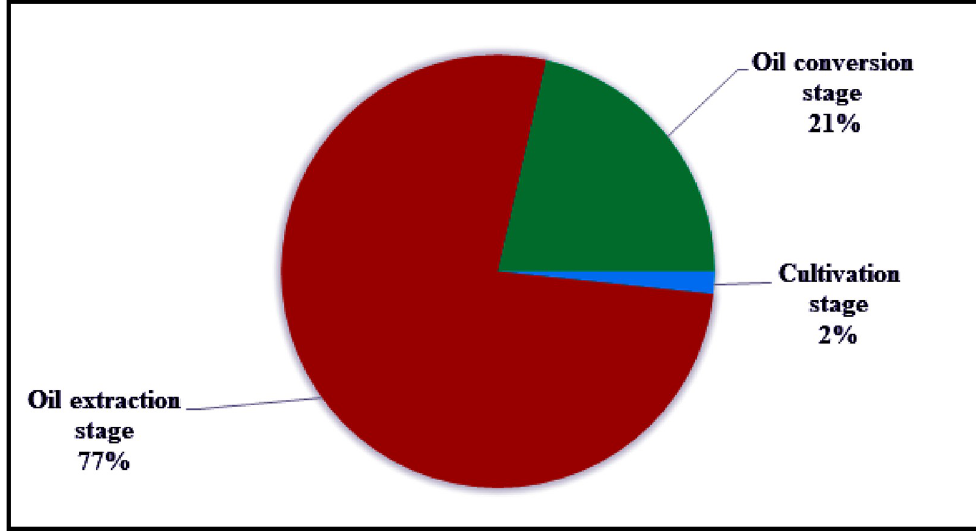
Fig 2. Percent contribution per process of three stages of JC biodiesel to various environmental impact